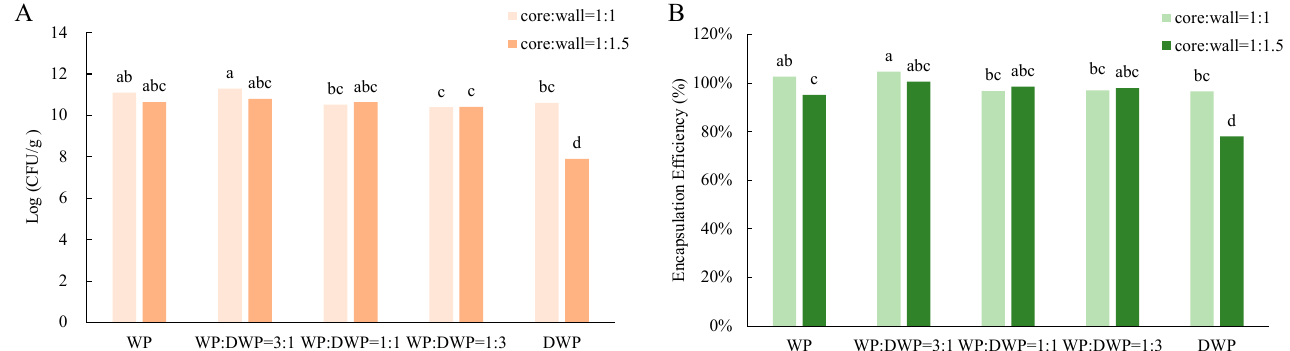
Figure 2. Cell number ( A ) and encapsulation efficiency ( B ) of microencapsulated L. plantarum 299v strain with different core-to-wall ratios and wall material ratios. WP: whey protein, DWP: denatured whey protein. Results are shown as the means and standard deviations. The superscript letters indicate significant differences ( p < 0.05).